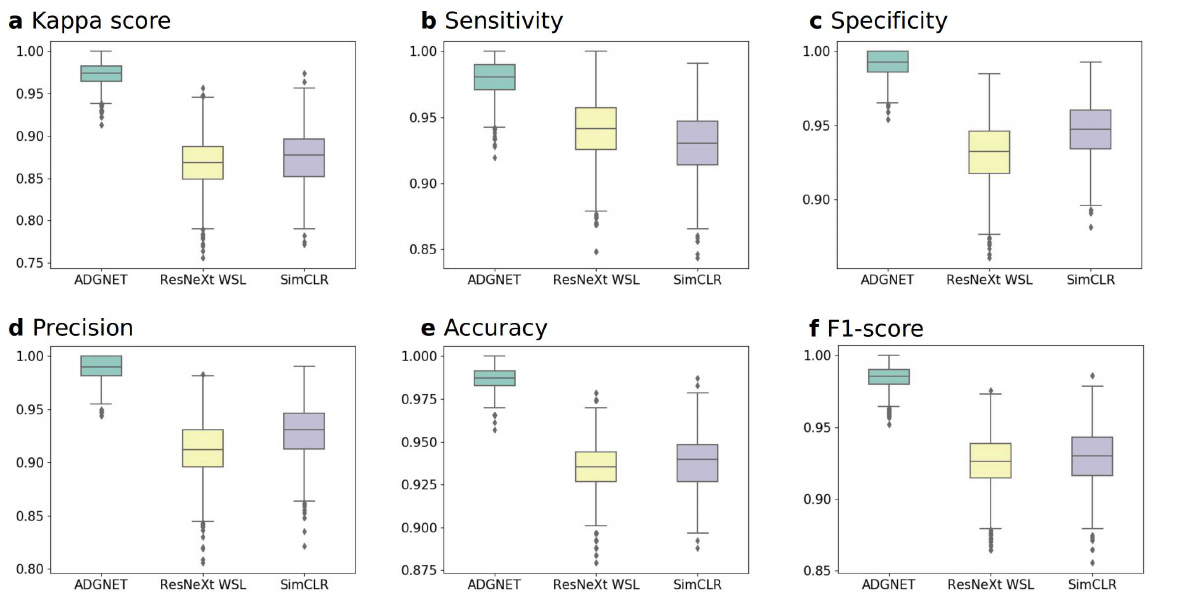
Figure 6. Boxplots of the six evaluation metrics of the models in experiment B. ( a ) kappa score. ( b ) sensitivity. ( c ) specificity. ( d ) precision. ( e ) accuracy. ( f )